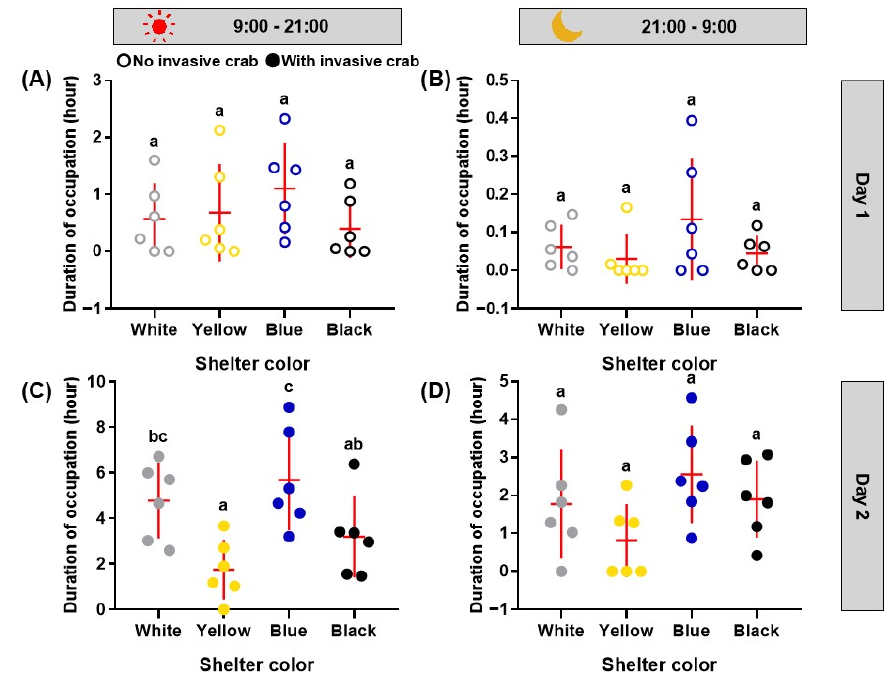
Figure 7. The duration of occupation of different colored shelters: the daytime of Day 1 ( A ), the nighttime of Day 1 ( B ), the daytime of Day 2 ( C ), and the nighttime of Day 2 ( D ). Each colored point represents the duration of occupation in each system. Different lowercase letters represent statistically significant differences in the duration of occupation ( p < 0.05).